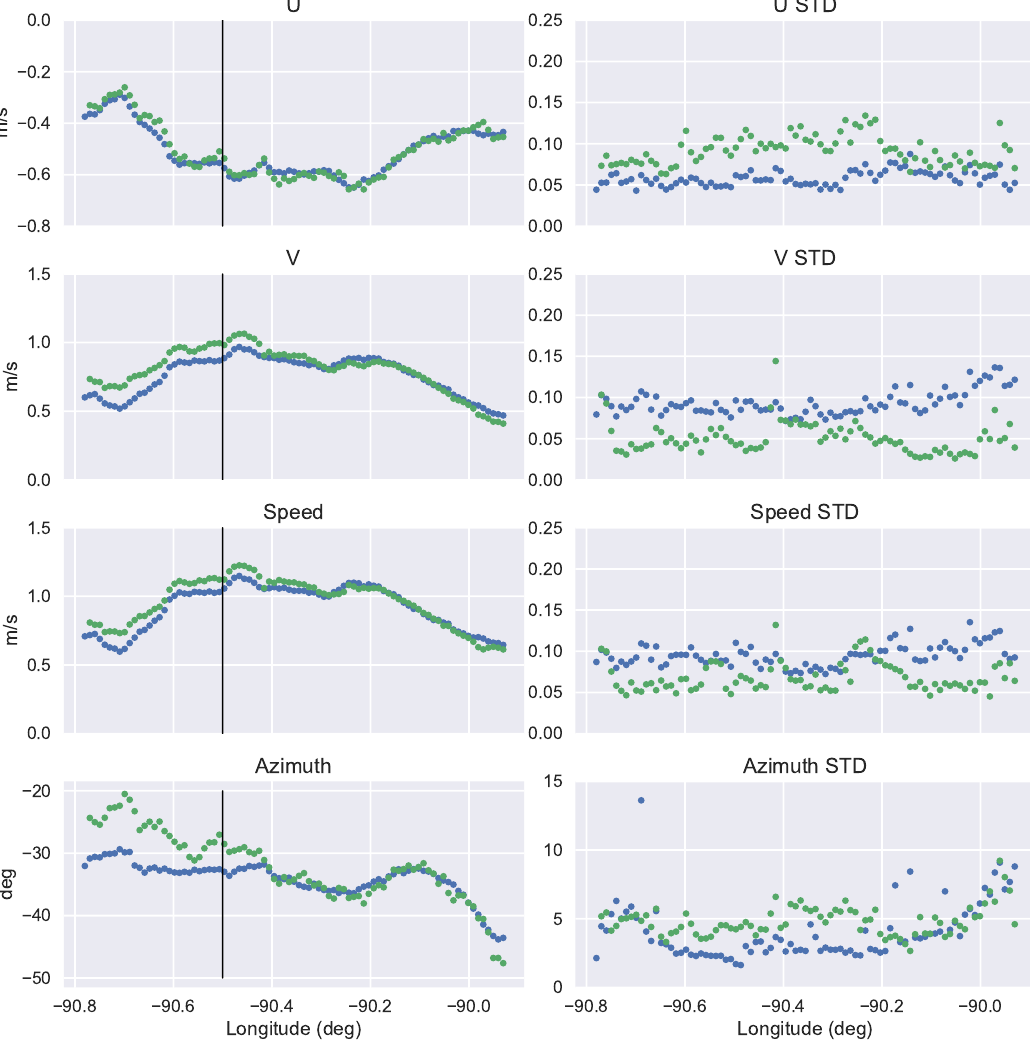
Figure 23. (right column) Parameter average over the 5km swath as a function of latitude for DopplerScatt (blue) and ROCIS (green). (right column) Standard deviation of the parameter for 1km longitude by 5km latitude bins. These standard deviations are estimates of the instrument noise, given that little variation in the current is expected over this size averaging cell. (top row) U component; (second row) V component; (third row) current speed; (bottom row) azimuth relative to north. Data for 26 March